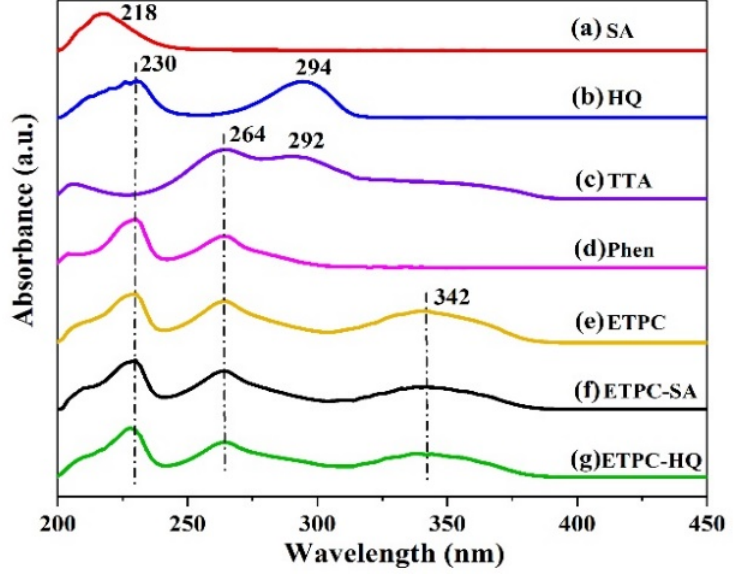
Figure 5. UV/vis absorbance curves: ( a ) SA, ( b ) HQ, ( c ) TTA, ( d ) Phen, ( e ) ETPC, ( f ) ETPC-SA, and ( g ) ETPC-HQ.